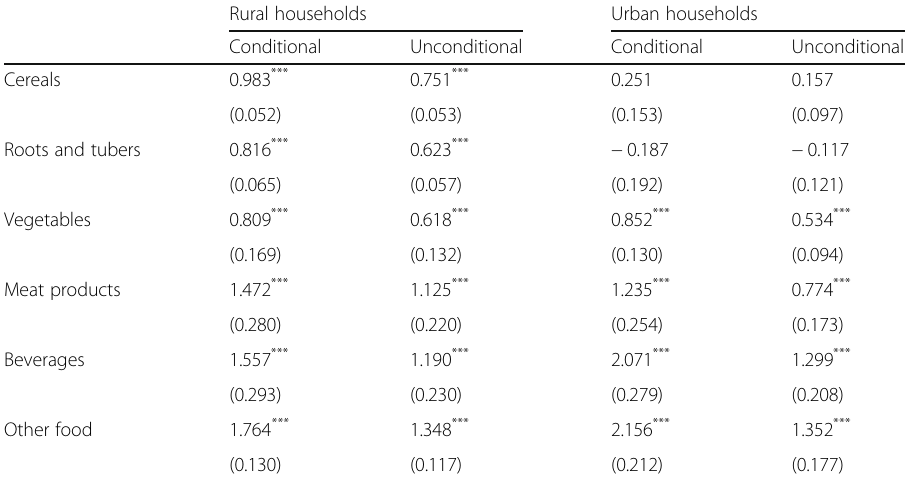
Table 4 Distribution of expenditure elasticities for all food group categories in Rwanda (computed at the sample